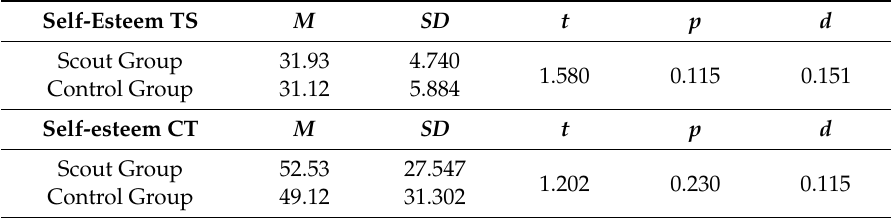
Table 2. t -test to contrast self-esteem levels between scout and non-scout teens.